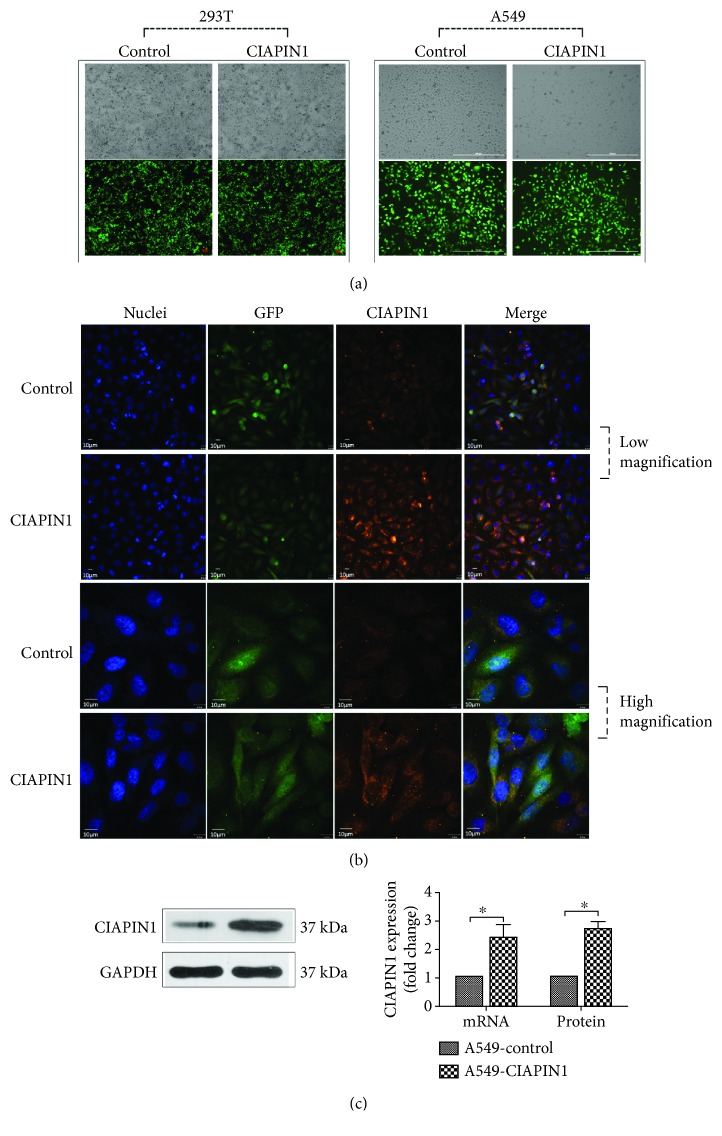
Validation of CIAPIN1 overexpression was assessed in A549 cells. (a) The representative photographs of 293T cells and A549 cells with GFP expression were shown. (b) The immunofluorescence assay was performed to detect the increase in CIAPIN1 observed with a confocal laser microscope. Blue indicated nuclei, green indicated GFP, and red indicated CIAPIN1 staining. (c) The mRNA and protein expressions of CIAPIN1 in A549 cells with CIAPIN1 overexpression were detected by real-time quantitative PCR and western blotting. Each value indicated the mean ± SD of three independent experiments. ∗P < 0.05, compared with control.